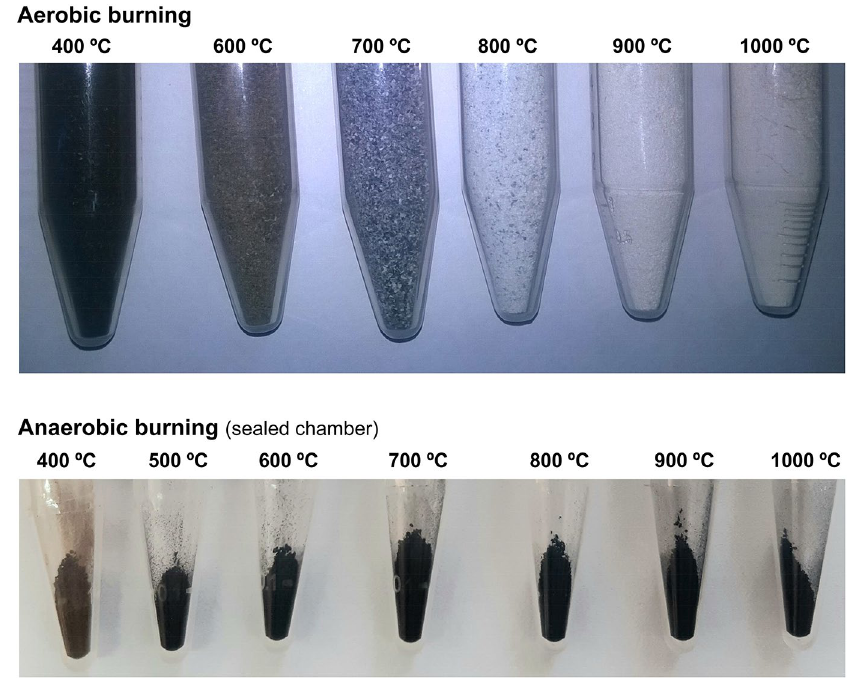
Figure 2. Human bone samples currently analysed, showing the colour changes according to the burning conditions—aerobic or anaerobic in a sealed chamber (An sealed